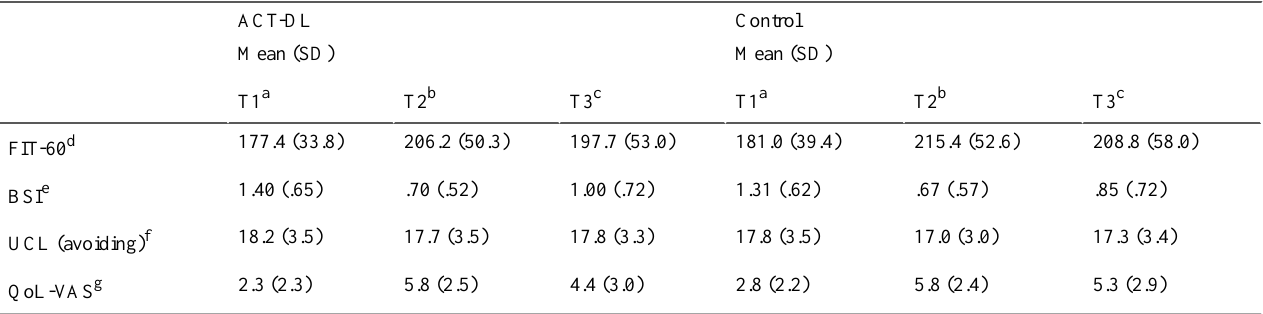
Table 2. Results of self-report questionnaires at different assessment time points for participants in the intervention (n=49) and control (n=112) groups in ACT in Daily Life Training